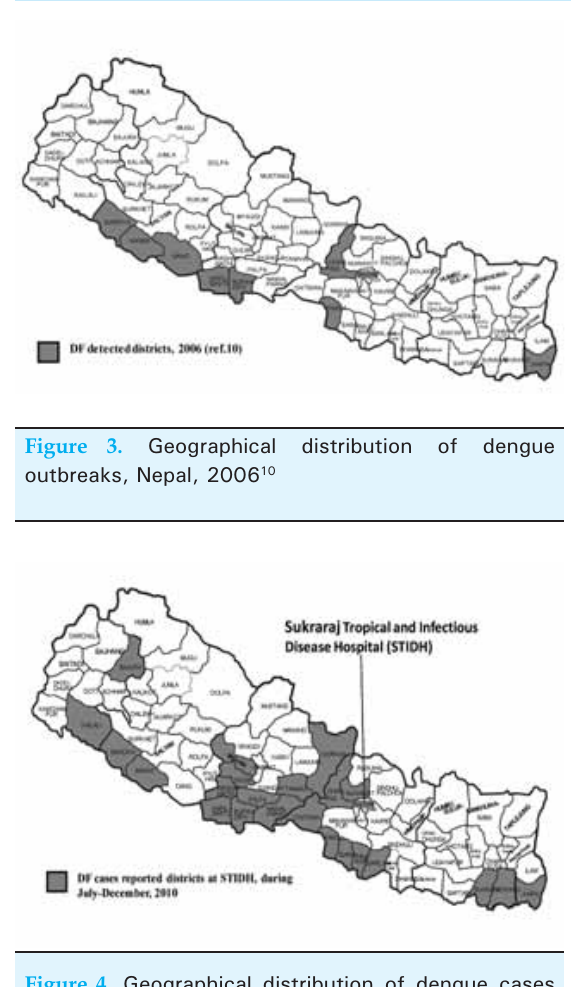
Figure 4. Geographical distribution of dengue cases admitted to STIDH, during July- December 2010, Kathmandu,